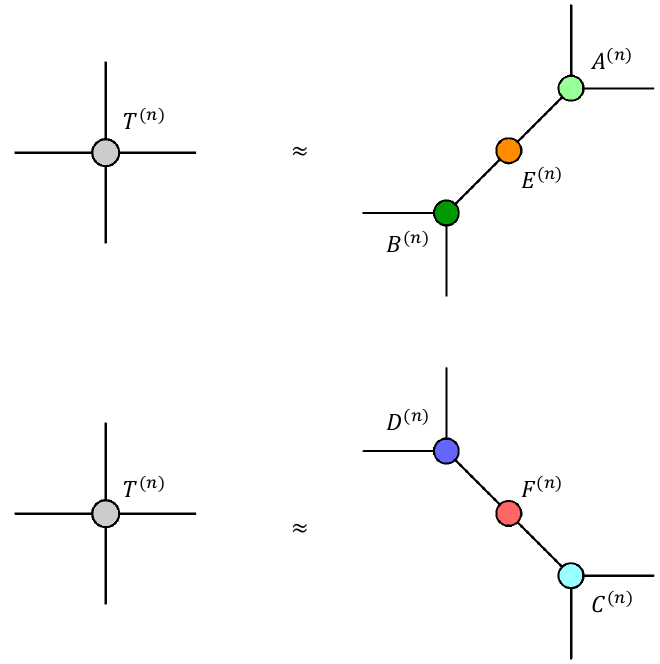
Figure 2 . (Top) Diagrammatic representation for eq. (2.5). Light and dark green symbols corre- spond to A ( n ) and B ( n ) , respectively. The orange symbol shows E ( n ) , which defines the new bond weight R ( n +1) via eq. (2.13). (Bottom) Diagrammatic representation for eq. (2.6). Light and dark blue symbols correspond to C ( n ) and D ( n ) , respectively. The red symbol shows F ( n ) , which defines the new bond weight S ( n +1) via eq. (2.14). Note that an extra sign factor should be associated with the left-hand side as in eq.